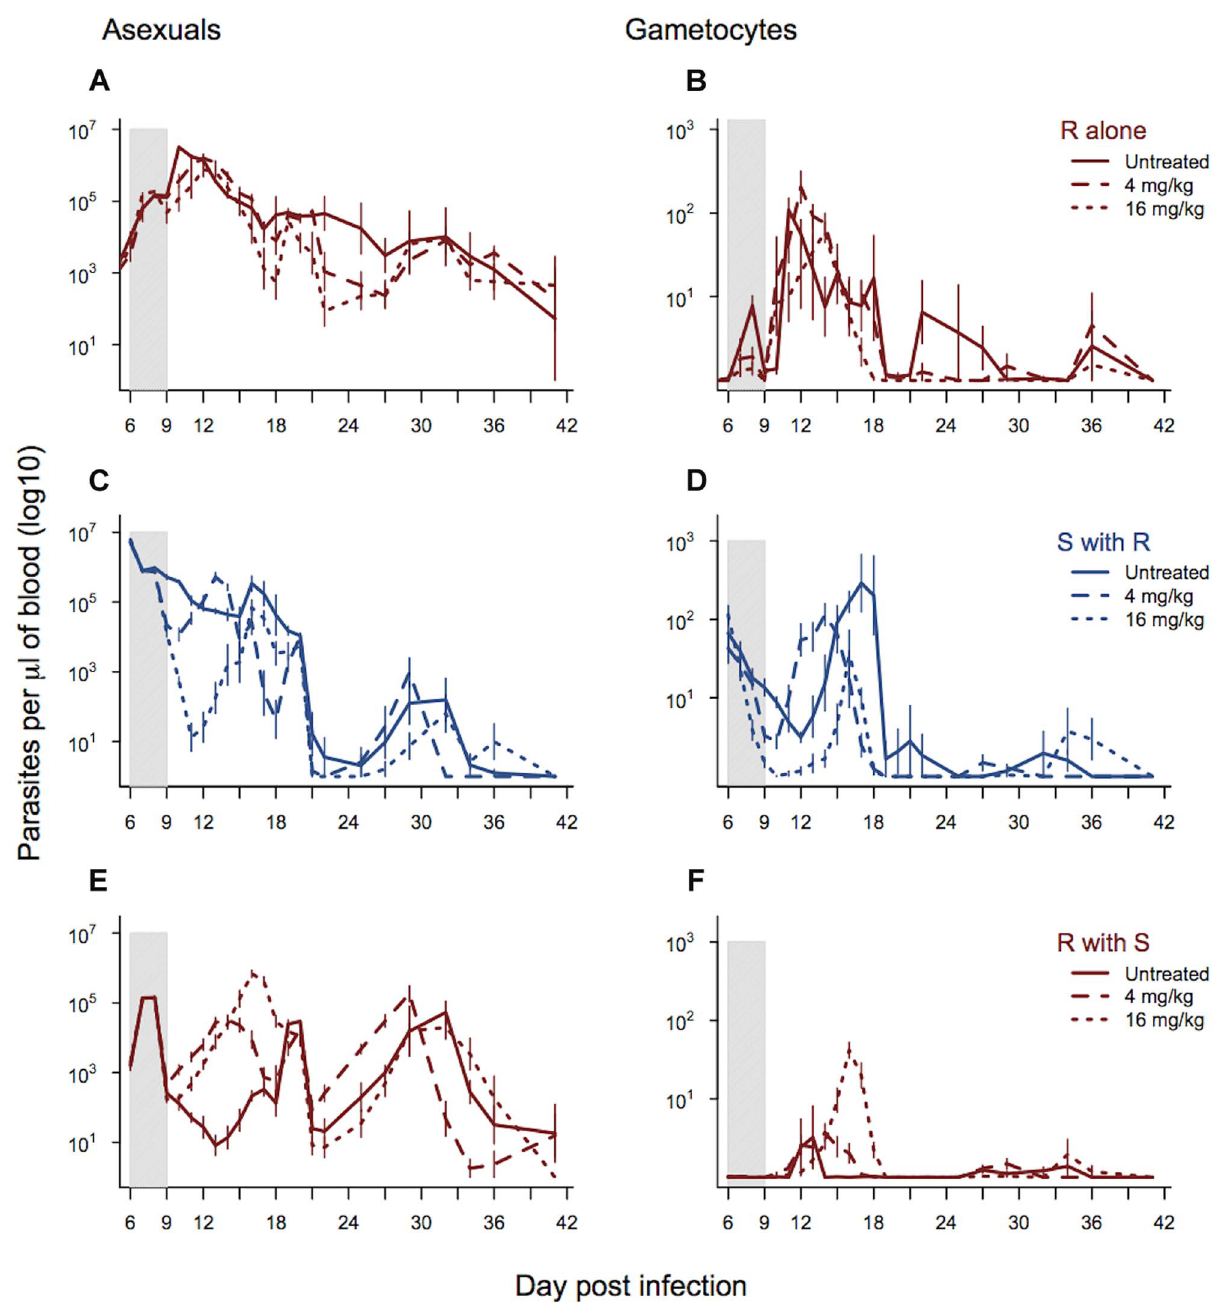
Figure 4. Dynamics of asexual and transmission stage parasites in single and mixed infections under three treatment regimes. Dynamics of asexual parasites (left panels) and gametocytes (right panels). Resistant parasites in single infections shown in panels a–b. Mixed infections shown in panels c–f with susceptible parasite dynamics in blue (c–d) and resistant parasite dynamics in red (e & f). Each line represents a treatment regime with the mean calculated from between 5 and 10 infections. Bars show the standard error of the mean. The shaded area shows the period of drug treatment. Data from experiment 3.